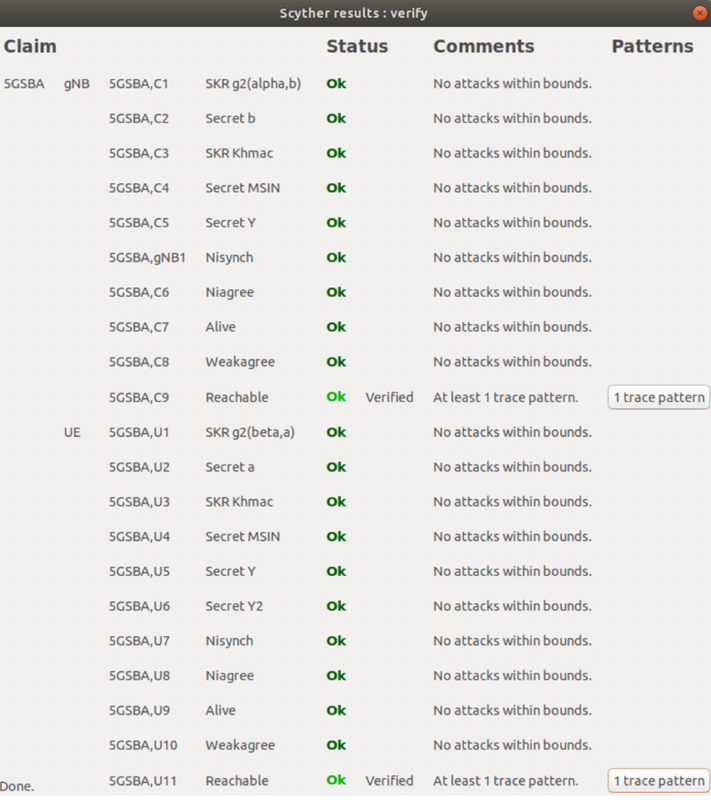
Figure 4. Formal verification with